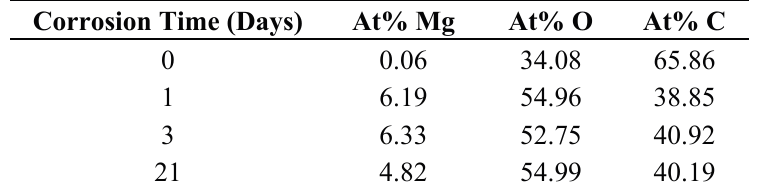
Table 1. EDX data on surface composition (atomic percent for the relevant elements Mg, O and C) of the PCL-coated magnesium structures after different corrosion intervals. Corrosion Time (Days) At% Mg